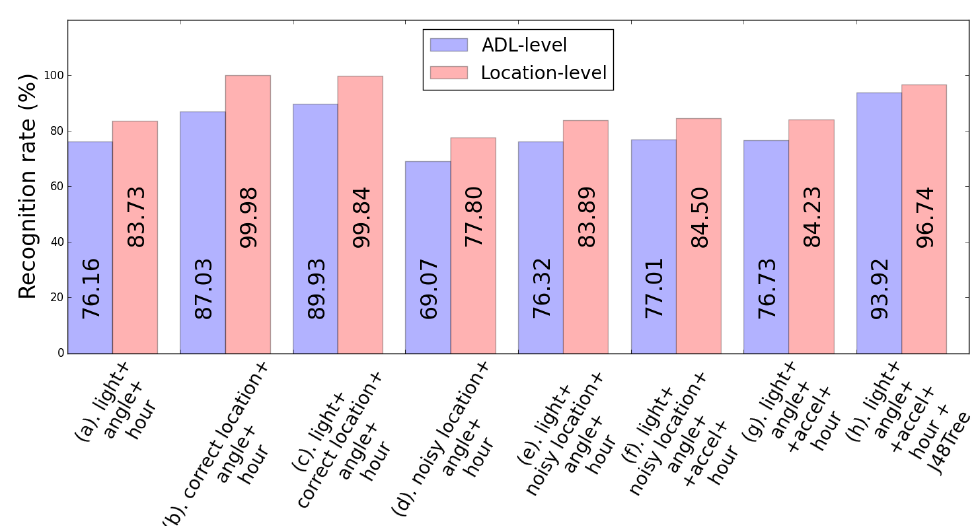
Figure 10. Comparison of recognition rates using different combinations of attributes. In the xlabel, “angle” represents that the orientation azimuth angle is leveraged; “correct location” mean that Wi-Fi-based localization outcomes with high-accuracy are imported here; “noisy location” means that wrong pre-recognized locations are imported deliberately for the purpose of